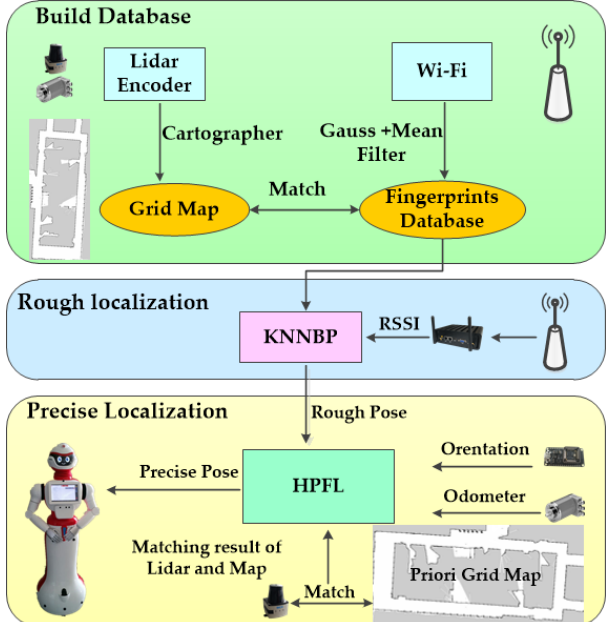
Figure 2. Multi-sensor fusion localization system flow. HPFL: hybrid particle filter localization; KNNBP: K nearest neighbors based on possibility; RSSI: received signal strength